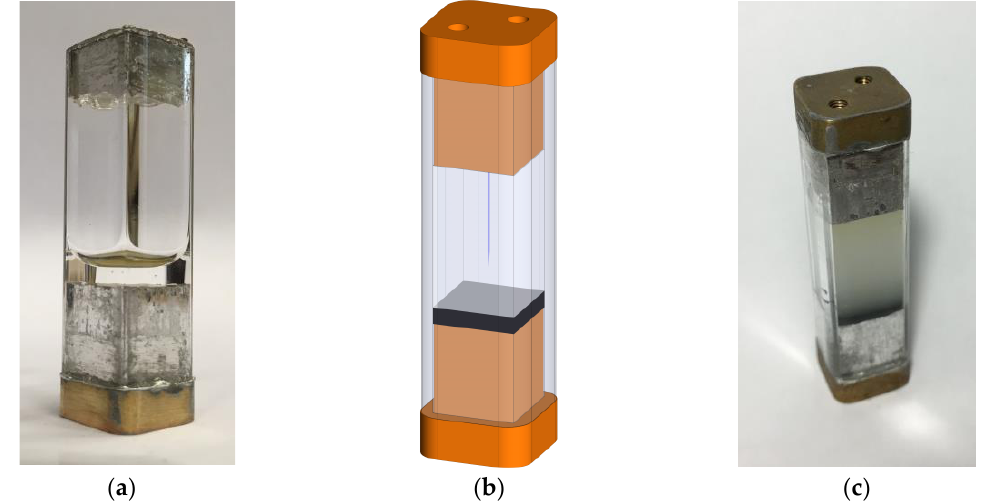
Figure 1. ( a ) The specimen capsule during assembly; ( b ) the geometry of the specimen capsule; and ( c ) the finished specimen capsule.